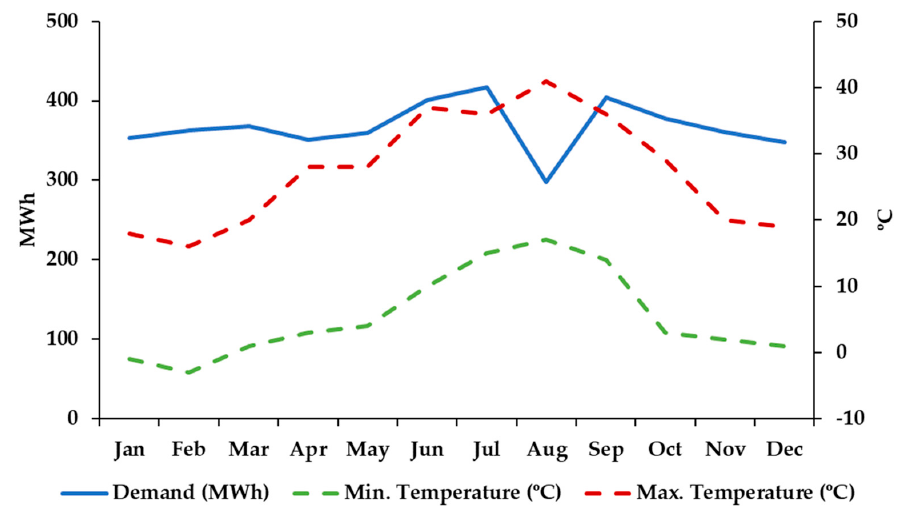
Figure 3. Monthly electricity demand, minimum (Tm) and maximum temperature (TM) in 2018 .